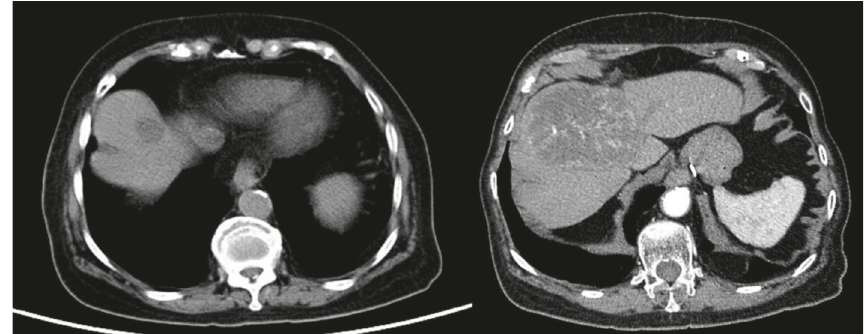
Figure 9: (a) Non-contrast CT abdomen of Patient B in October 2017 showing reduction of liver metastasis 8 months after mitotane (compared with Figure 7). (b) Contrast CTabdomen of Patient B in April 2018 showing the progression of liver metastasis 14 months after